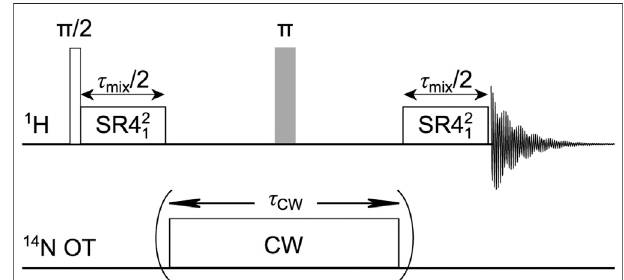
FIGURE 2 | 1 H- 14 N OT-REDOR sequence. On 1 H channel, SR4 2 recoupling is used to reintroduce the 1 H- 14 N dipolar couplings. On 14 N OT channel, CW pulse is used to perturb 14 N OT populations. For the fraction curve, two sets of data ( S 0 and S ′ ) are acquired by employing OT- REDOR sequence without and with CW pulse (within the two brackets),